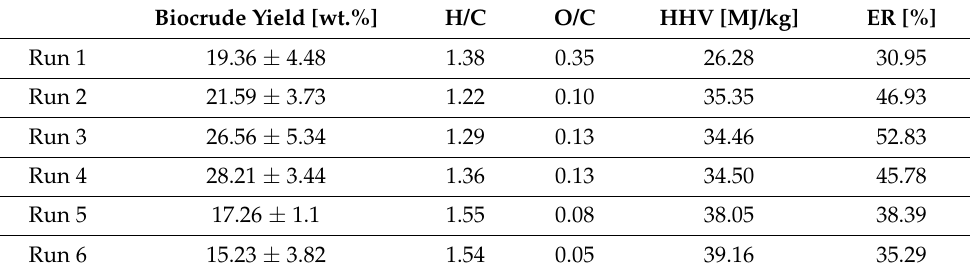
Table 2. Summary of HTL biocrude yields and key quality parameters, including H/C and O/C ratios and higher heating values and energy recovery rates. DAF basis was used when calculating the biocrude yields.